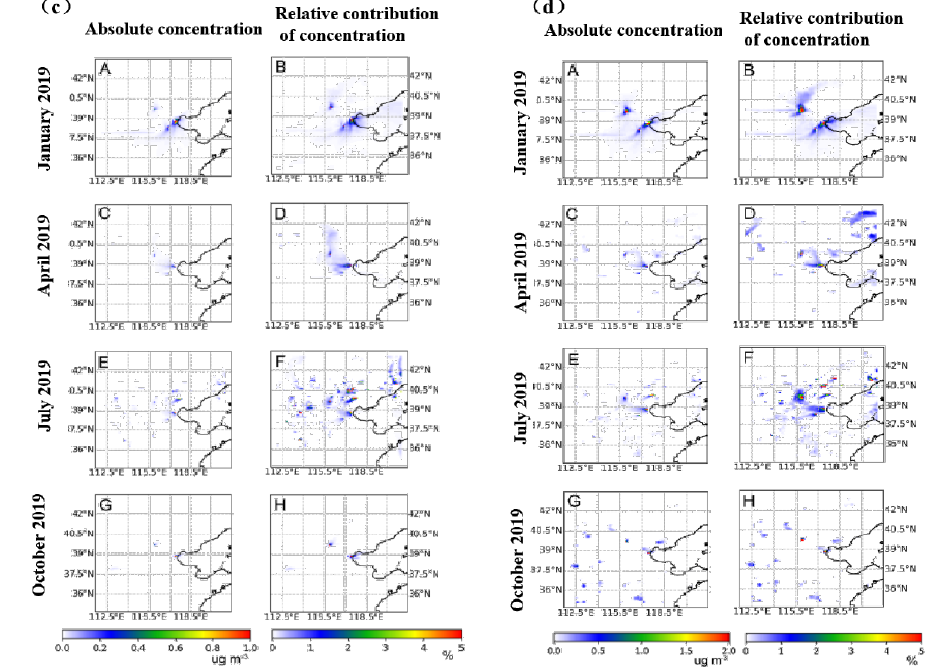
Figure 5. Distribution of air pollutants (( a ) PM 2.5 , ( b ) MDA8 O 3 , ( c ) SO 2 , ( d ) NO 2 ) concentrations and relative contribution driven by emissions from four typical petrochemical enterprises in 2019.